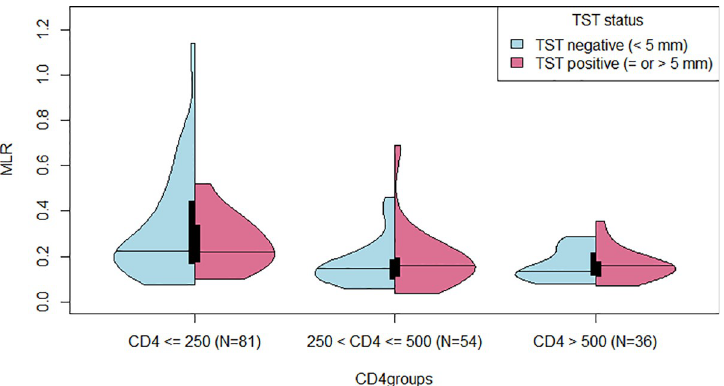
Fig 2. MLR stratified by TST status (negative vs positive TST result) and CD4 count category ( � 250, 250 < CD4 � 500, > 500 cells/mm 3 ). The medians are displayed by horizontal lines and interquartile ranges by black boxes. MLR = monocyte-to-lymphocyte ratio; TST = tuberculin skin